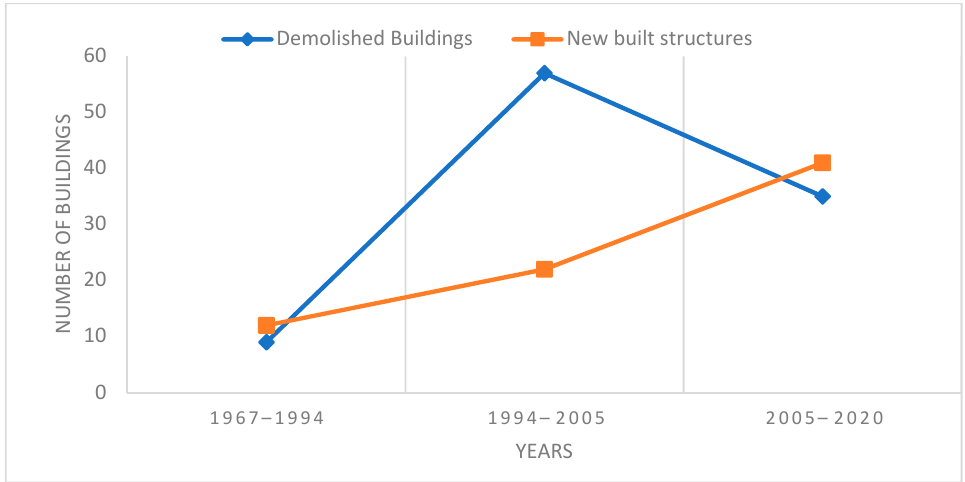
Figure 6. Summary of demolitions and new buildings (1967–2020). (Source: Author, 2020).